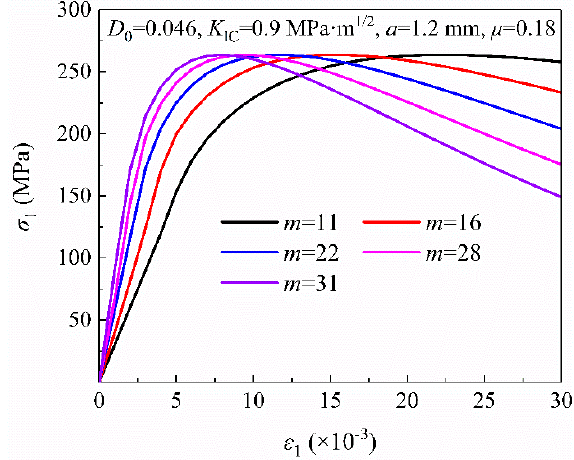
Figure 13. Effects of parameter m on stress-strain relationship.